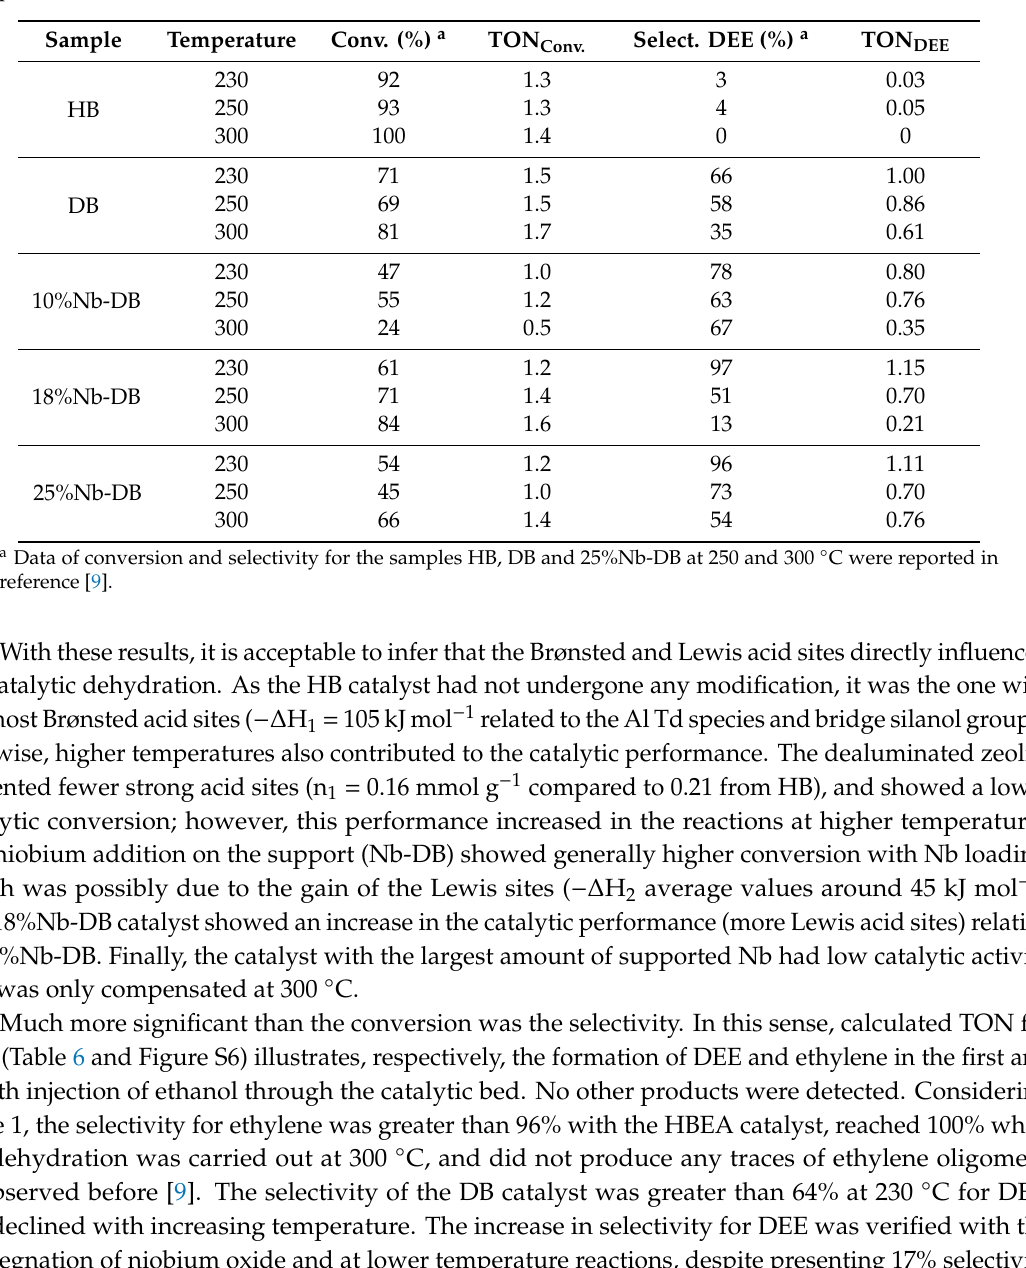
Table 6. Turnover number (TON) for ethanol conversion (TON Conv. ) (mole converted ethanol / mole acid sites), selectivity for diethyl ether (DEE) and TON DEE (mole obtained DEE / mole acid sites) after 50 pulses of